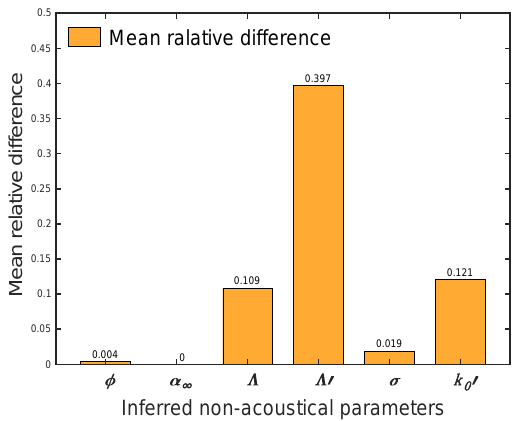
Figure 8. Mean relative differences of inferred non-acoustic parameters.